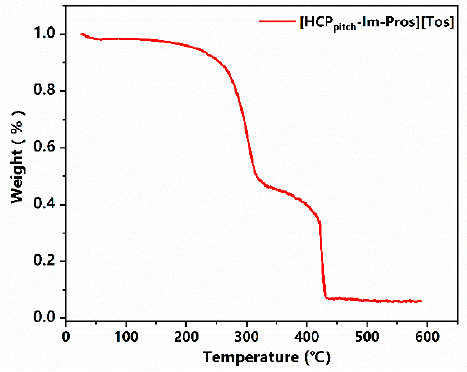
Figure 4. The TG curve of the [HCP pitch –Im–Pros][Tos] catalyst sample.